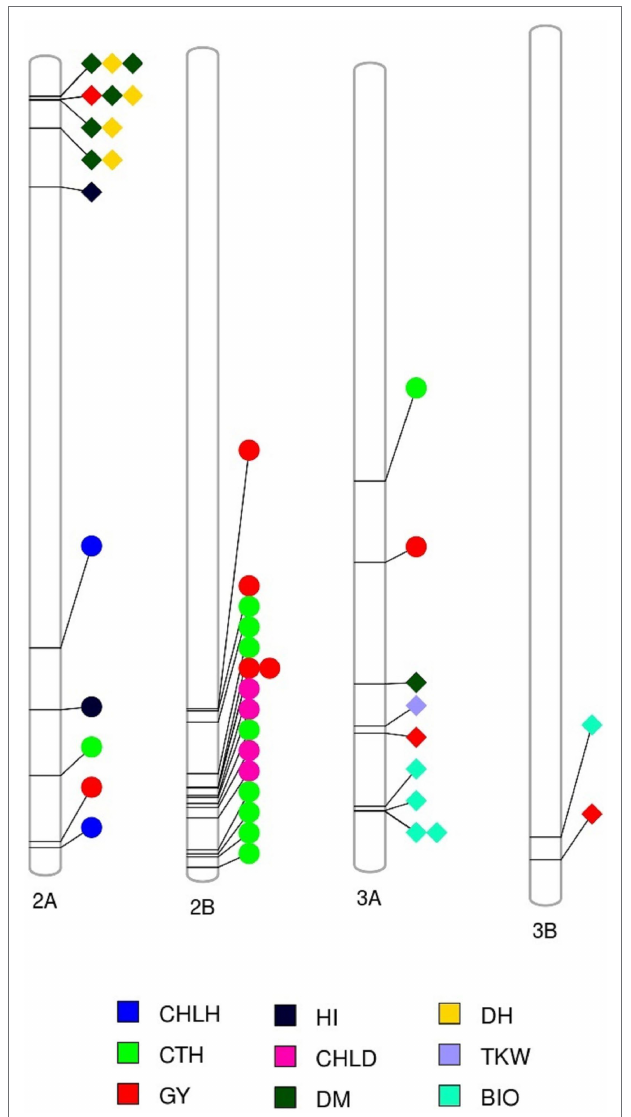
FIGURE 6 | Markers associated with multiple traits (see color key legend in the figure) identified under favored environment at Dongola (circles) or severe heat stress environment at Wad Medani (MED/SD2; diamonds). BIO, biomass; CHLD, chlorophyll degradation; CHLH, chlorophyll at heading; CTH, canopy temperature at heading; DH, days to heading; DM, days to maturity; GY, grain yield; HI, harvest index; TKW, thousand kernel